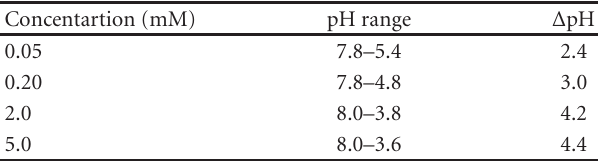
Table 2: Change in pH at various concentrations of Na 2 HPO 4 . Concentartion